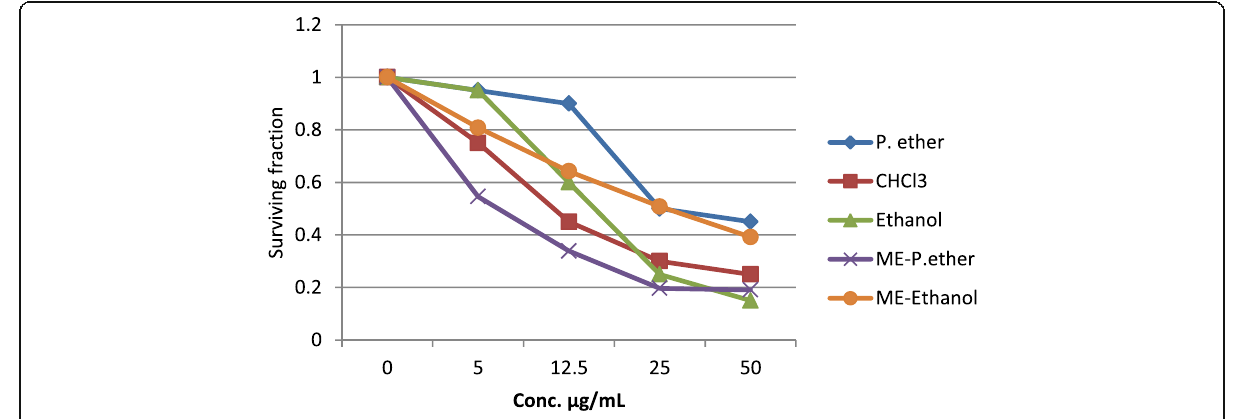
Fig. 5 Cytotoxicity of Thevetia peruviana extracts and ME formulations on breast carcinoma cell